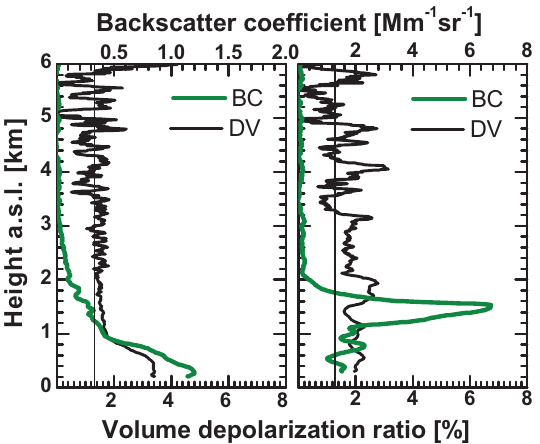
Figure 1. 532nm particle backscatter coefficient (BC, green) and volume linear depolarization ratio (DV, black) measured on 2 days with almost particle-free conditions above 2–3km height. The ver- tical lines indicate DV=1.3%. This value was used in the data anal- ysis as Rayleigh depolarization ratio (clear air